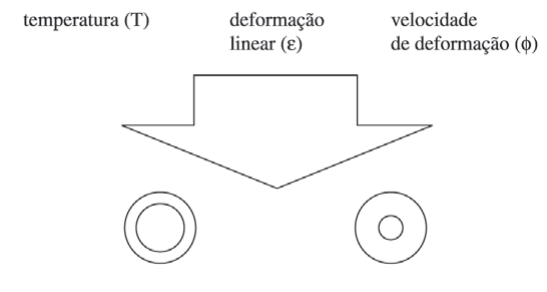
vados na Tabela